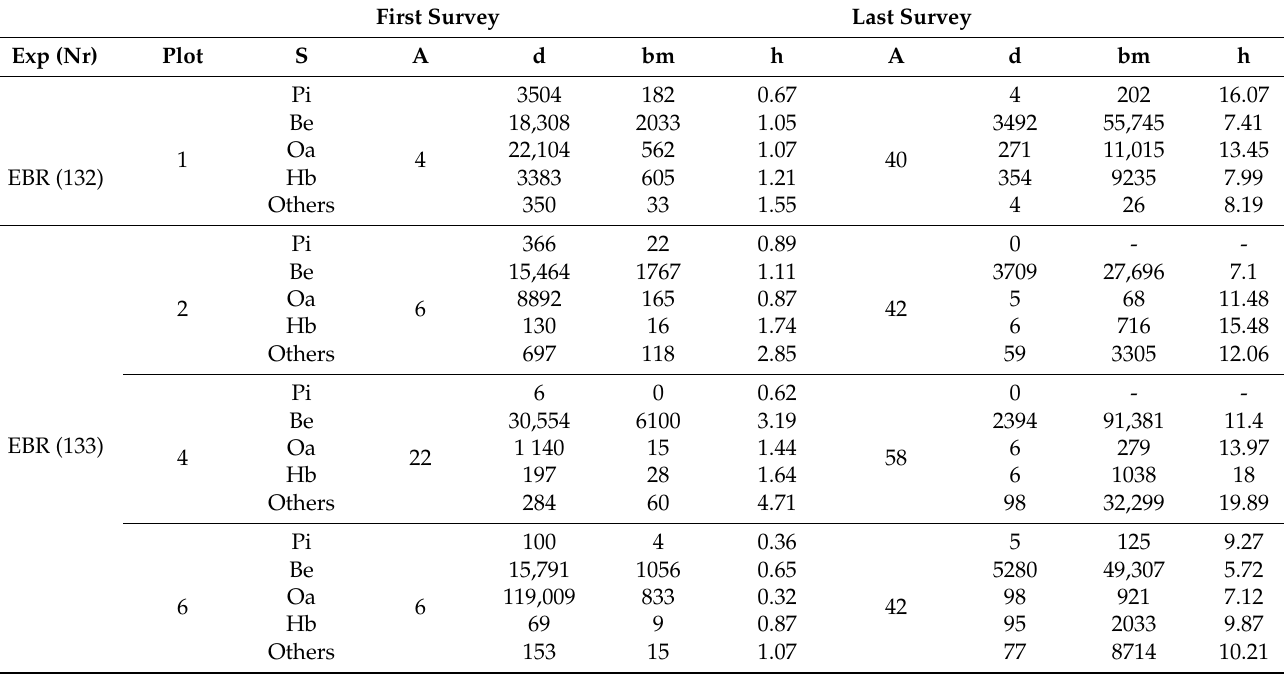
Table 3. Regeneration data for the first and latest survey; S—tree species; A—age of